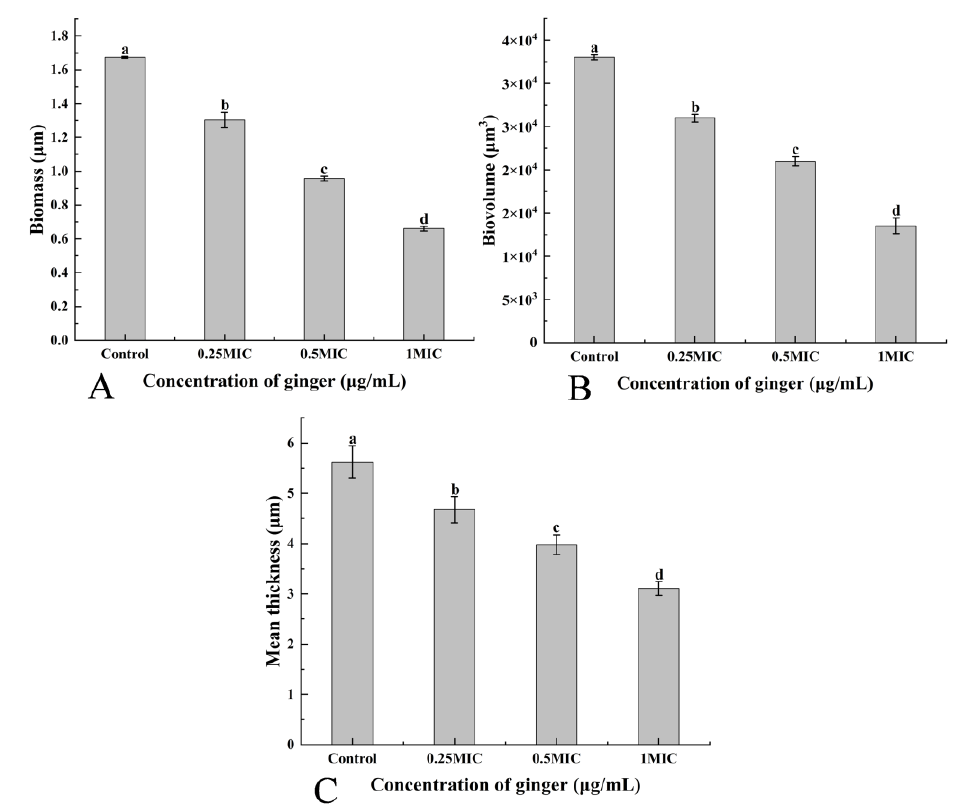
Figure 6. ( A ) biomass, ( B ) biovolume, and ( C ) mean thickness. ( A – C ) show the three CLSM indicators of biofilms at different GEO concentrations, respectively. Different lowercase letters indicate significant difference ( p < 0.05).